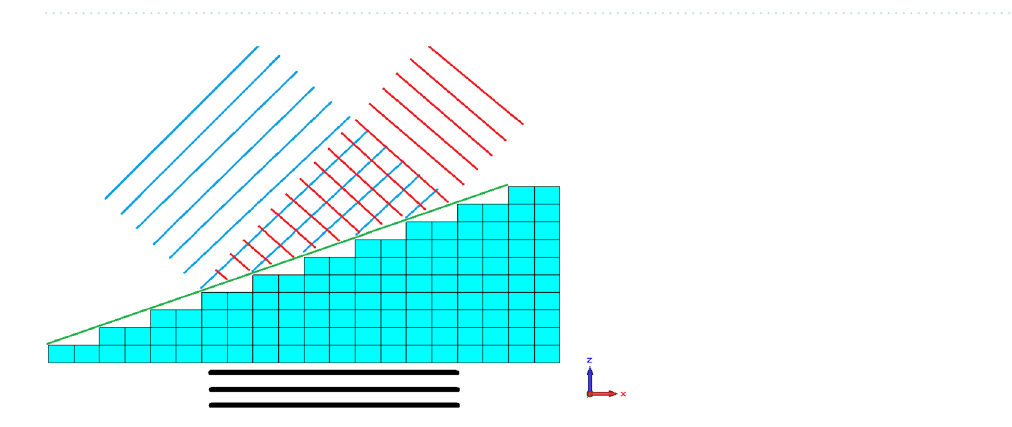
with permission from 27 © The Optical Society) and our own results in ( b ).